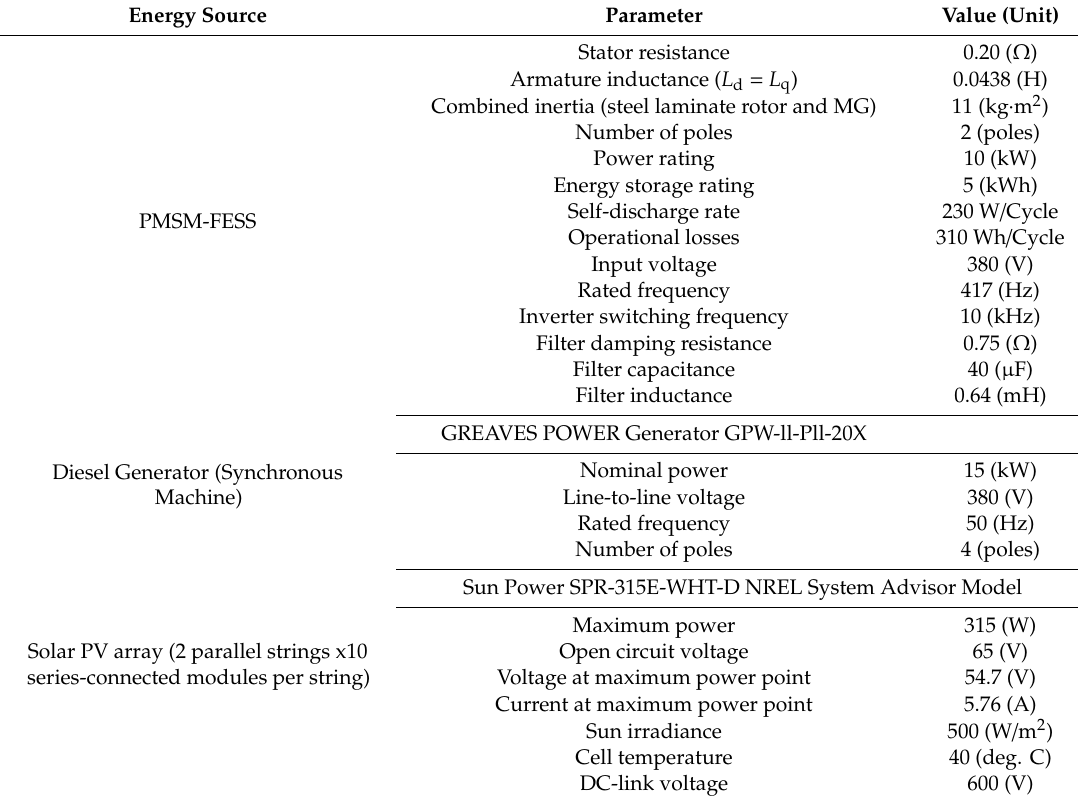
Figure 17. Diesel engine fuel consumption relative to the load. Table 1. Parameters of the hybrid FESS-PV-DGen